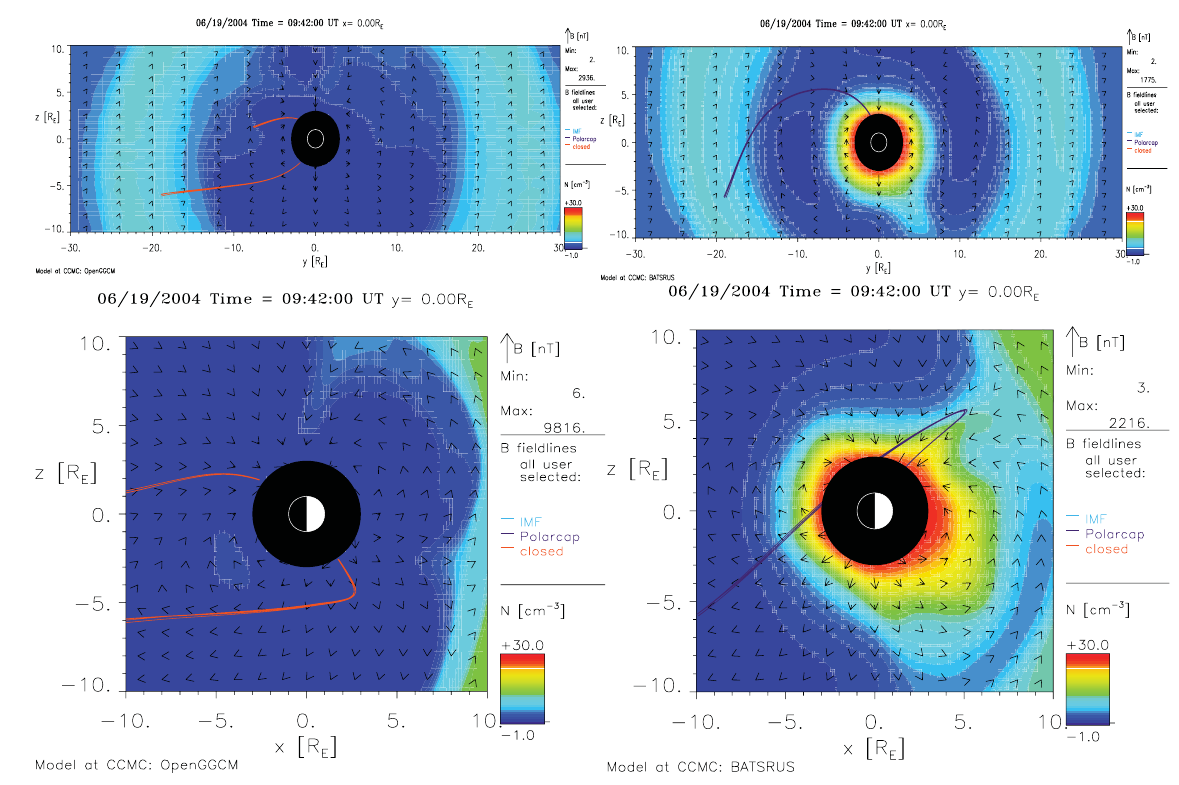
Fig. 9. Difference in the global MHD model’s projected field lines which the Cluster constellation encountered through during the KHI for Event 6. The top- and bottom-left images were produced from OpenGGCM and the top- and bottom-right images were produced from BATS-R-US. The spacecraft coordinates can be references from Table 1. Each panel illustrates the magnetic field direction using a black arrow and density using the color